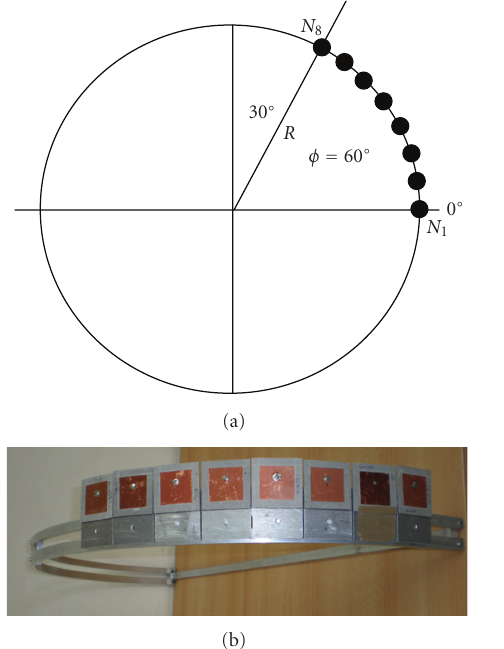
Figure 5: (a) Geometry of antenna. (b) Realized antenna array.